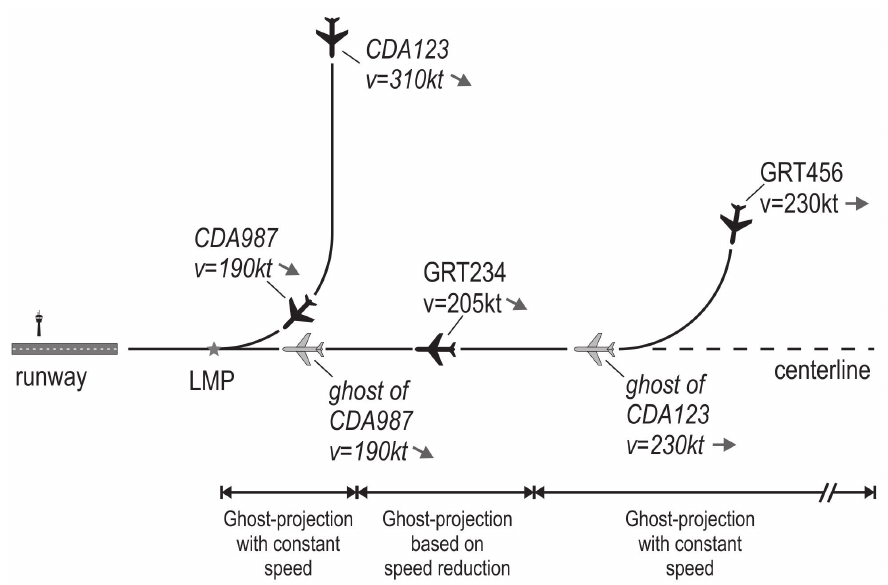
Figure 4. The working principle of 3-segment ghosting. GRT234 and GRT456 are regularly guided aircraft; CDA123 and CDA987 are aircraft (4D-FMS) conducting an long-distance independent approach. The two CDAs are “ghosted” onto the final approach and centreline by adjusting their position calculations in the typical approach procedure of the manually guided